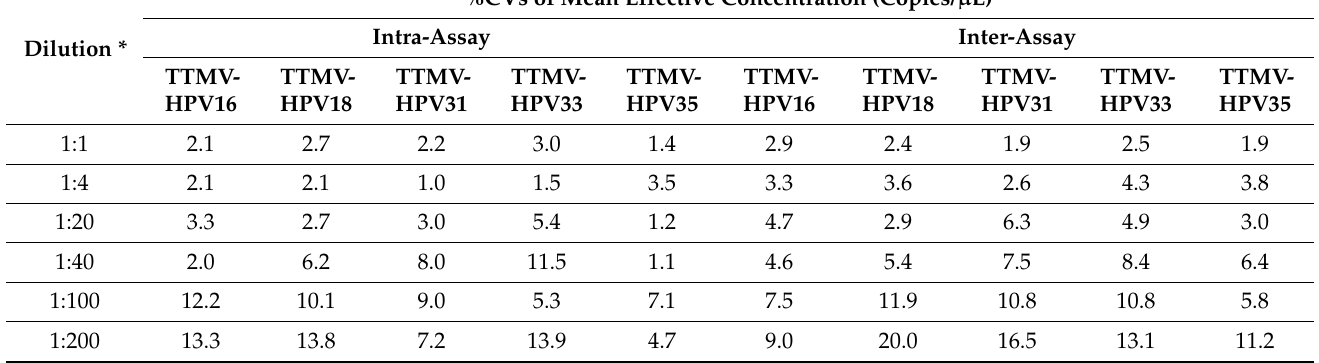
Table 4. Intra-assay precision (repeatability) and inter-assay precision (within-lab on differing days), reflected by percent relative standard deviations of effective concentrations of the five TTMV-HPV DNA types measured at six concentrations in